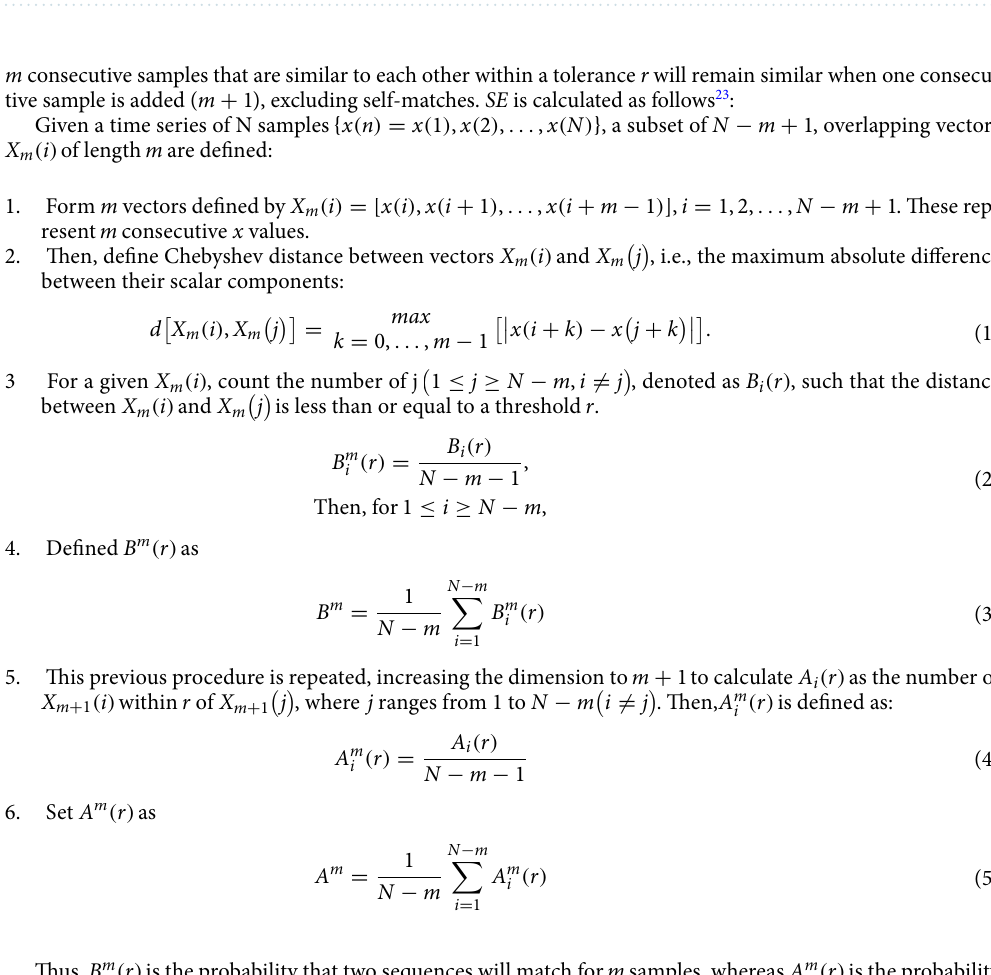
Table 1. Patient characteristics. APACHE II: Acute Physiology and Chronic Health Evaluation. ICU intensive care unit, LOS length of stay, MV mechanical ventilation, RASS Richmond Agitation-Sedation